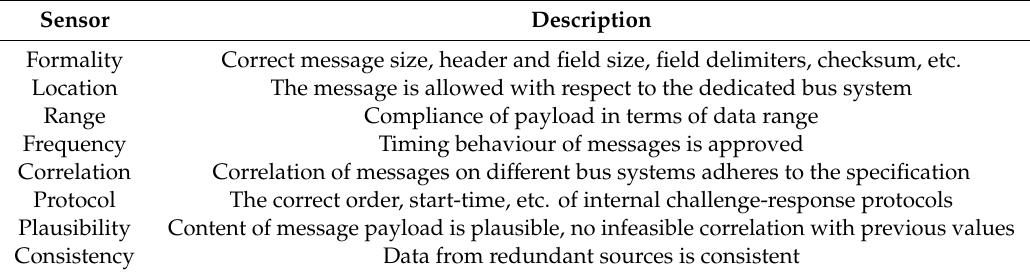
Table 4. Automotive anomaly detection sensors